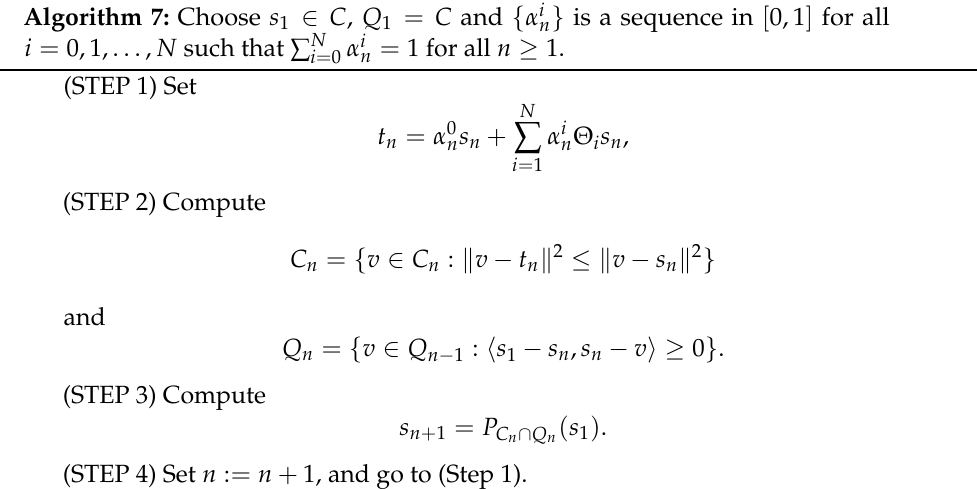
Algorithm 7: Choose s 1 ∈ C , Q 1 = C and { α i